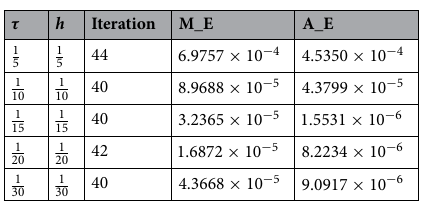
Table 1. Numerical results for the Example 1, where γ = 0.1 .